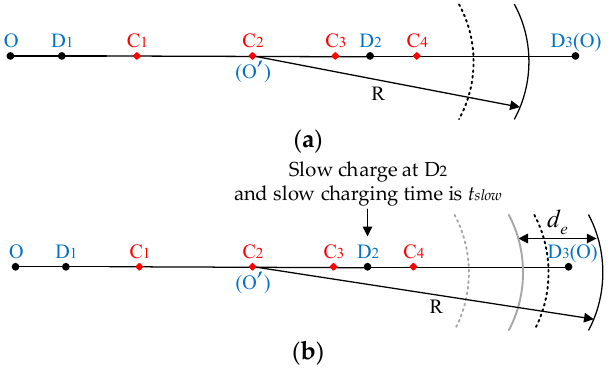
Figure 12. The feasibility analysis of the trip chain considering slow charge; ( a ) analyze the feasibility of the trip chain without considering slow charge; ( b ) analyze the feasibility of the trip chain considering slow charge.